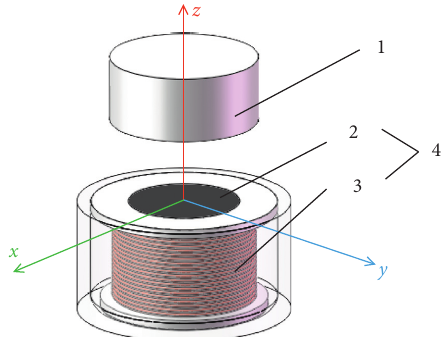
Figure 1: Magnetoelectric hybrid suspension. 1, permanent magnet; 2, iron core; 3, coil; 4, electromagnet.